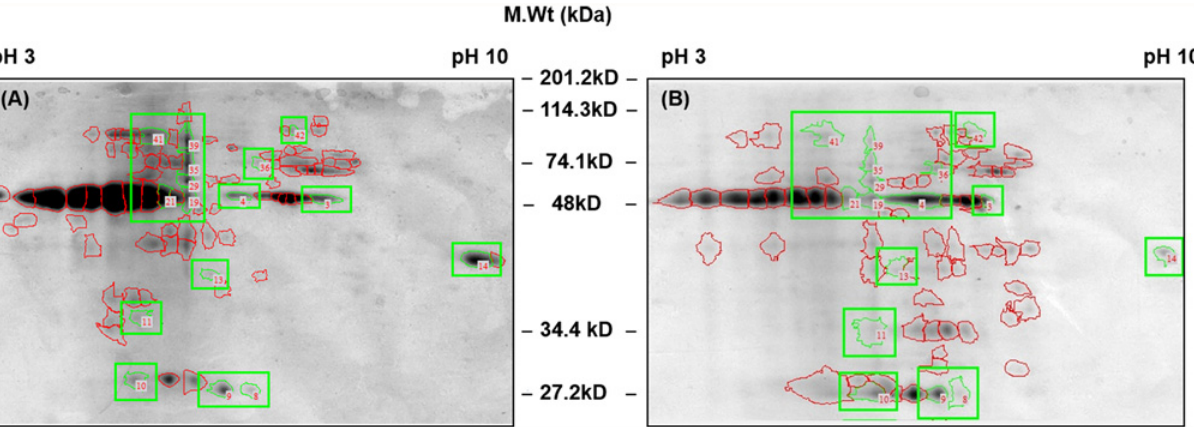
Fig 3. Differential spot selection of salivary gland protein in An . stephensi species. Representation of the protein spots showing upregulated and downregulated expression in An . stephensi strains are marked by green line. Molecular weights (kDa) are shown in the middle of 2D gel. (A) Silver-stained gel of An . stephensi susceptible strain (B) Silver-stained gel of An . stephensi multi-resistant strain. Depiction of total 16 spots marked using ImageMaster 2D Platinum 7.0 software. Downregulated proteins: Match spot id (3,13,14,21,29,35,39); Upregulated proteins: Match spot id (4,8,9,10,11,19,36,41,42).